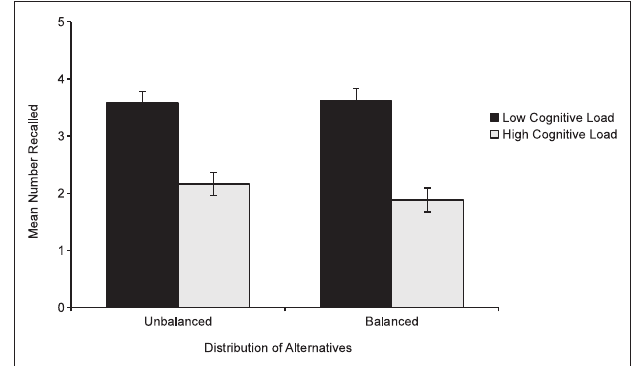
FiGure 5 | Mean number of alternatives recalled for the high and low cognitive-load conditions as a function of distribution type for experiment 3.